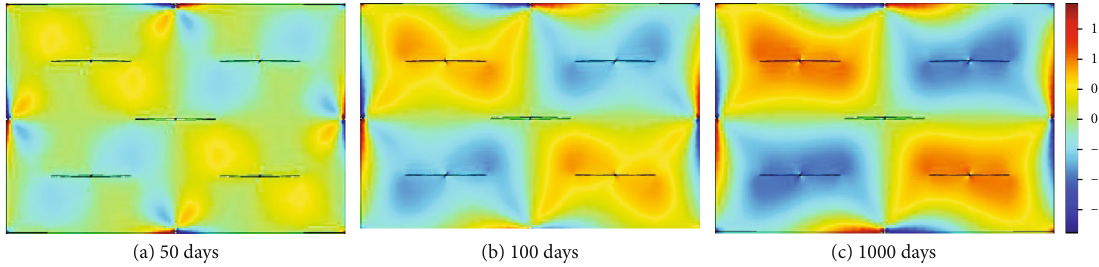
Figure 11: Shear stress distribution in di ff erent developing